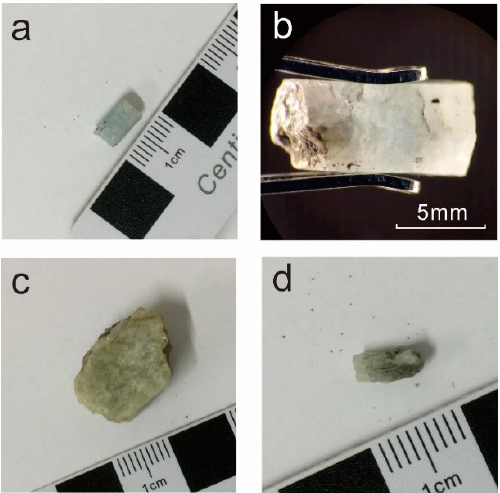
Figure 4. ( a , c , d ) The aquamarine crystals L1 to L3 of Longzi County, Tibet. ( b ) 40× gem microscope, dark-field observation specimen A-1, the size of A-1 is 3 × 3 × 8 mm.